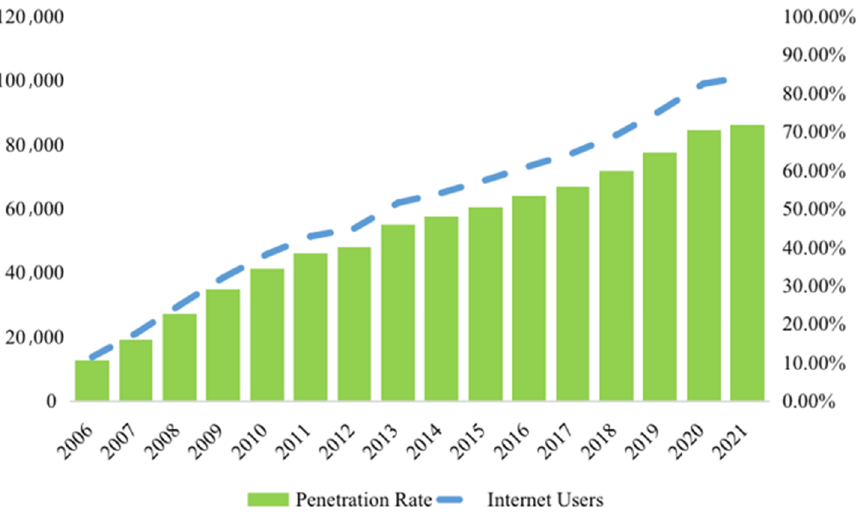
Figure 2. The development trend of the scale of Internet users in China from 2006 to Figure 2 . The development trend of the scale of Internet users in China from 2006 to 2021.